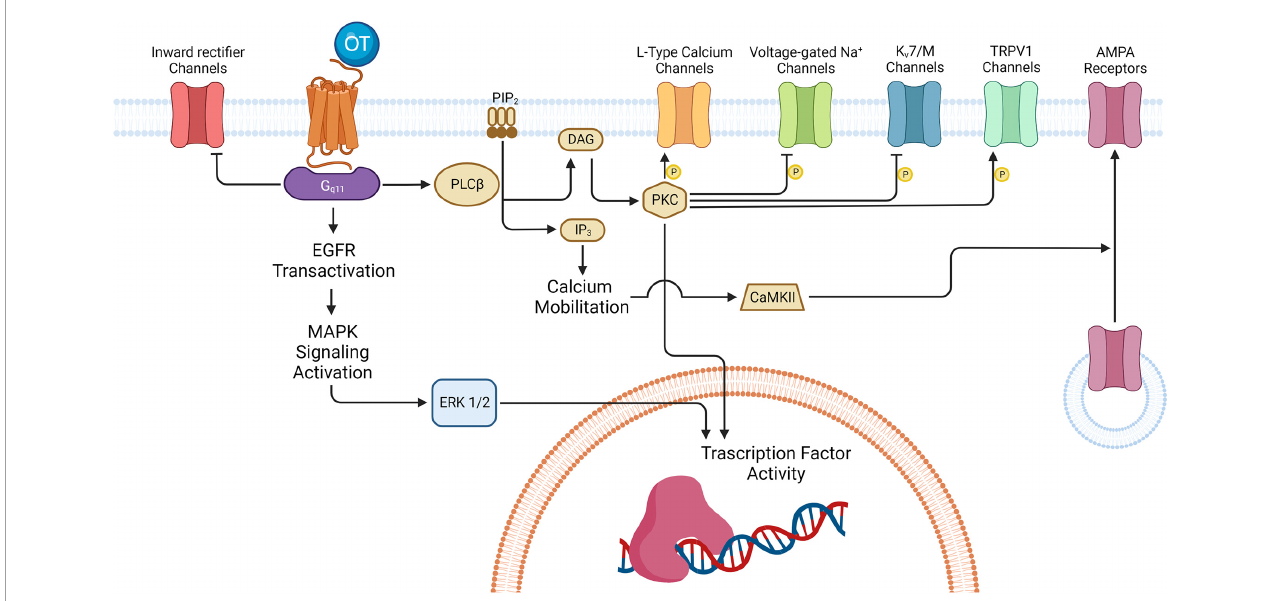
FIGURE6 Oxytocinergic-mediated intracellular signaling in hippocampus. The various effects exerted by OT in the several regions of the hippocampus are all ascribable to the activation of the 7-transmembrane domain G protein-coupled receptors for oxytocin (OTR). In the hippocampus, OTR is usually coupled to G q / 11 that activates various signaling cascades with different downstream effects, depending on the hippocampal region and neuronal type involved. One of the pathways activated by G q / 11 leads to the inhibition of the inward rectifier K + channels: this is one of the mechanisms possibly implicated in the depolarization of the CA1 FS-INs. Also, G q / 11 can induce activation of the mitogen-activated protein kinase (MAPK) cascade culminating in the extracellular signal-regulated kinase 1/2 (ERK1/2) translocation to the nucleus and the activation of transcription factors involved in long-term plasticity processes. Besides, G q / 11 determines activation of phospholipase C β (PLC β ) which leads to protein kinase C (PKC) activation and the subsequent phosphorylation of different targets (i.e., L-Type Ca 2 + channels in CA1 GABAergic interneurons, voltage-gated Na + channels and the Kv7 channels in the PYR neurons of CA2/CA3; TRPV1channels in the PYR of the Subiculum). In some cases, PKC can also activate different transcription factors thus promoting gene expression. In parallel, PLC can also bring IP3-mediated increase in the intracellular Ca 2 + which, by activating calcium/calmodulin-dependent protein kinase II (CAMKII), promotes α -amino-3-hydroxy-5-methyl-4-isoxazolepropionic acid receptor (AMPAR) recruitment at the entorhinal (EC)-CA2 synapses to support synaptic potentiation. DAG, diacylglycerol; IP 3 , inositol 1,4,5-trisphosphate; PIP 2 , phosphatidylinositol 4,5-bisphosphate. Created with